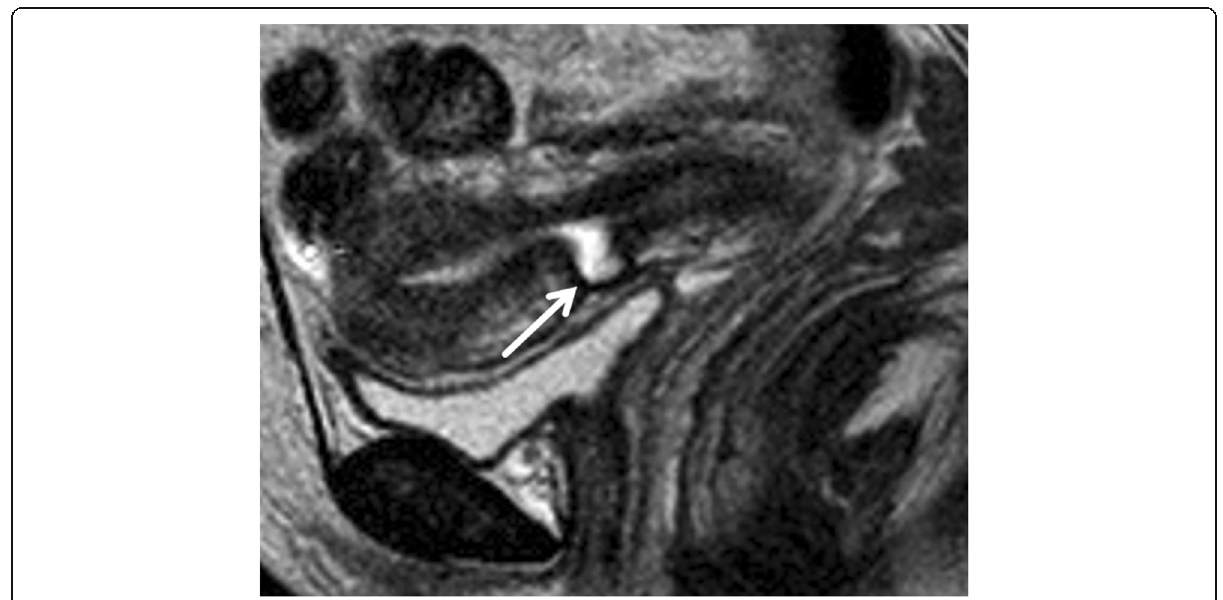
Fig. 9 A 40-year-old woman underwent to MR for abnormal uterine bleeding. CSD is detected on T2WI as a myometrium defect with apex pointing anteriorly, located at the anterior isthmus (white arrow)